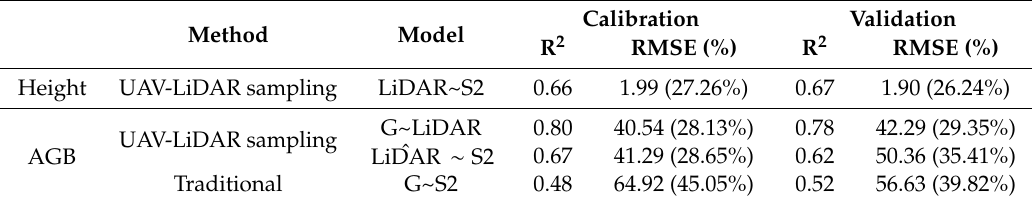
Table 4. Calibration and validation results of the height and AGB models.